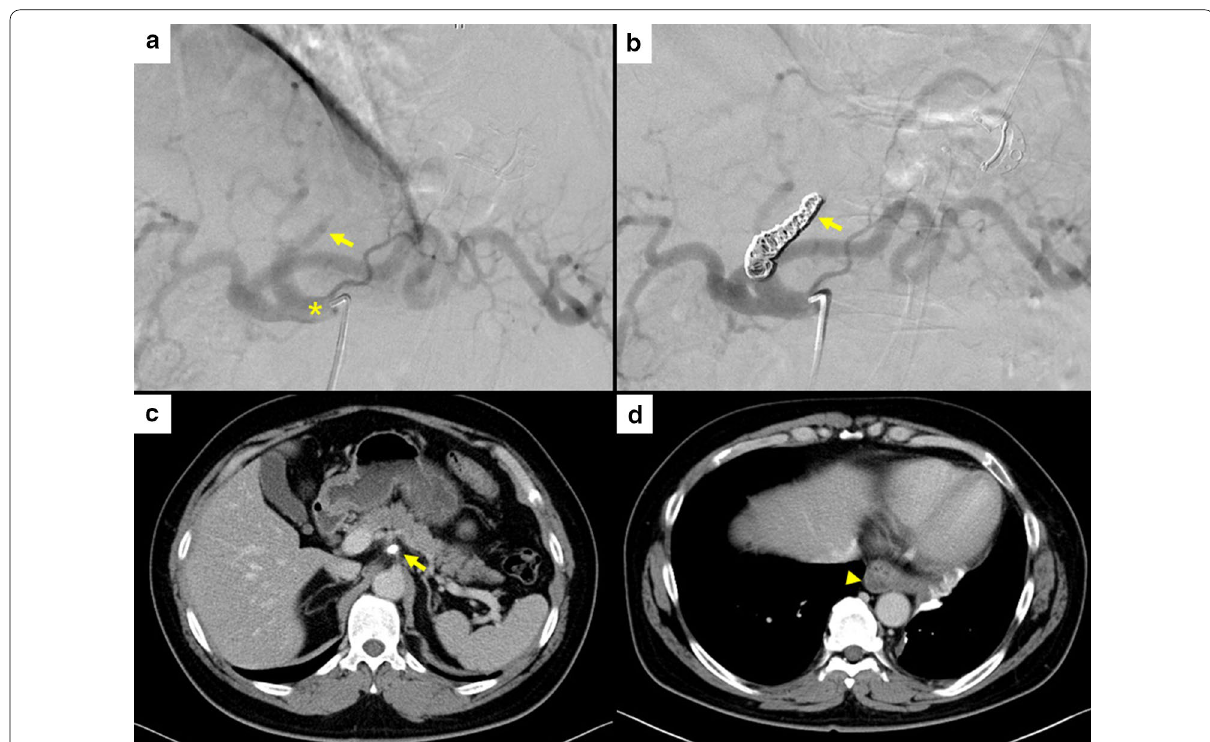
Fig. 3 Interventional radiology and postoperative computed tomography images. a Celiac angiography (asterisk) showing slight residual blood flow in the aberrant artery (yellow arrow). b After coil embolization, the aberrant artery was found to be completely occluded (yellow arrow). c Computed tomography image showing occlusion of the aberrant artery at the celiac artery 6 months after surgery (yellow arrow). d Computed tomography image showing the shrunken remnant aberrant artery 6 months after surgery (yellow